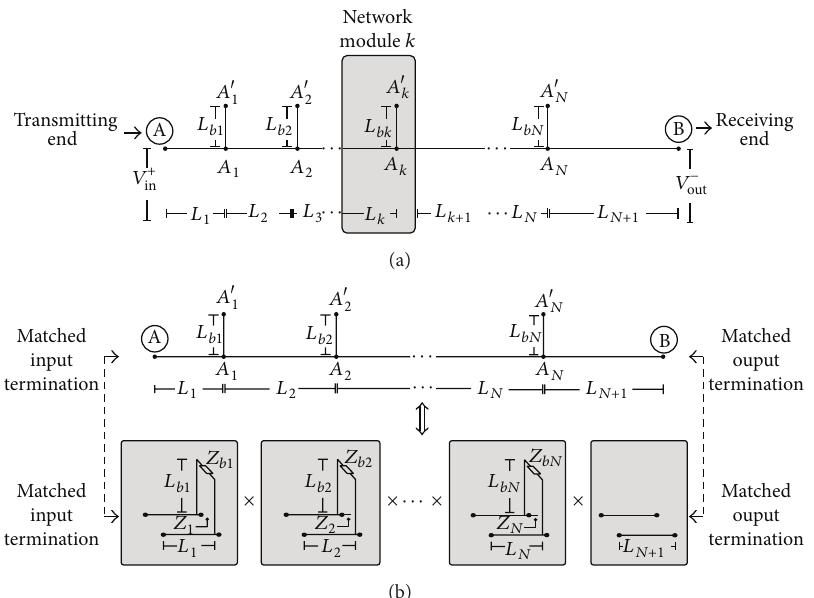
Figure2:(a)End-to-endBPLconnectionwith N branches.(b)AnindicativeBPLtopologyconsideredasacascadeofmodulescorresponding to N branches